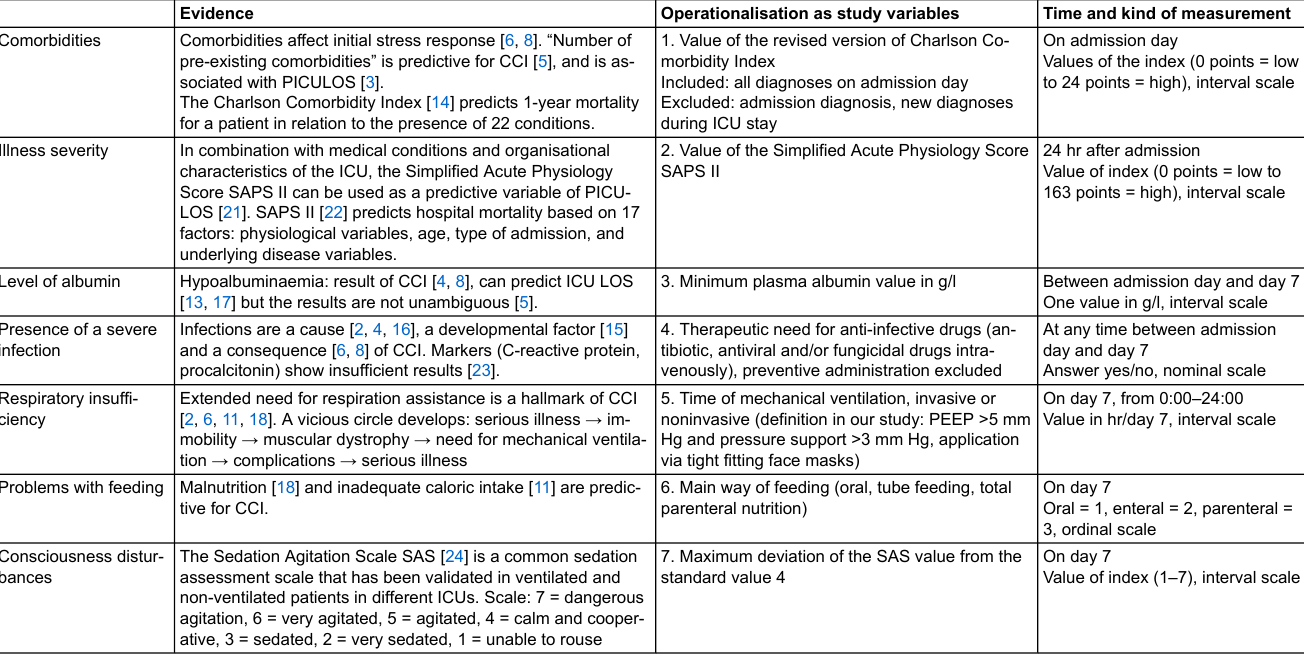
Table 1: Aspects of CCI and derivation of factors to predict on day 7 a long surgical ICU Stay (>20 d). Evidence Operationalisation as study variables Time and kind of measurement